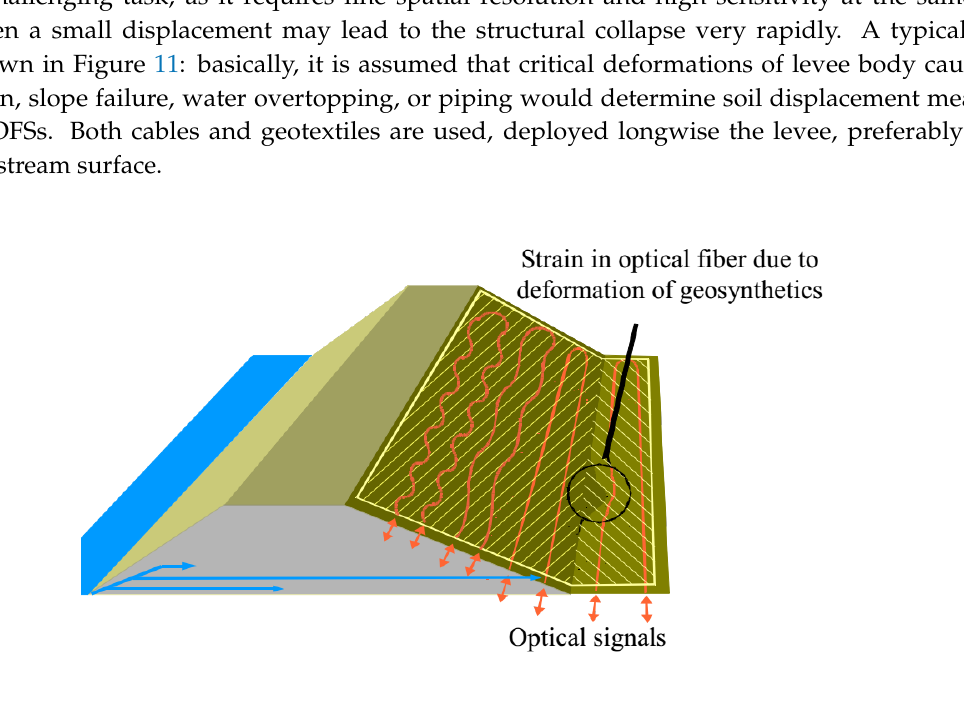
Figure 11. A schematic representation of the application of distributed optical fibre sensors (DOFSs) for strain sensing in a levee, using geotextiles (from